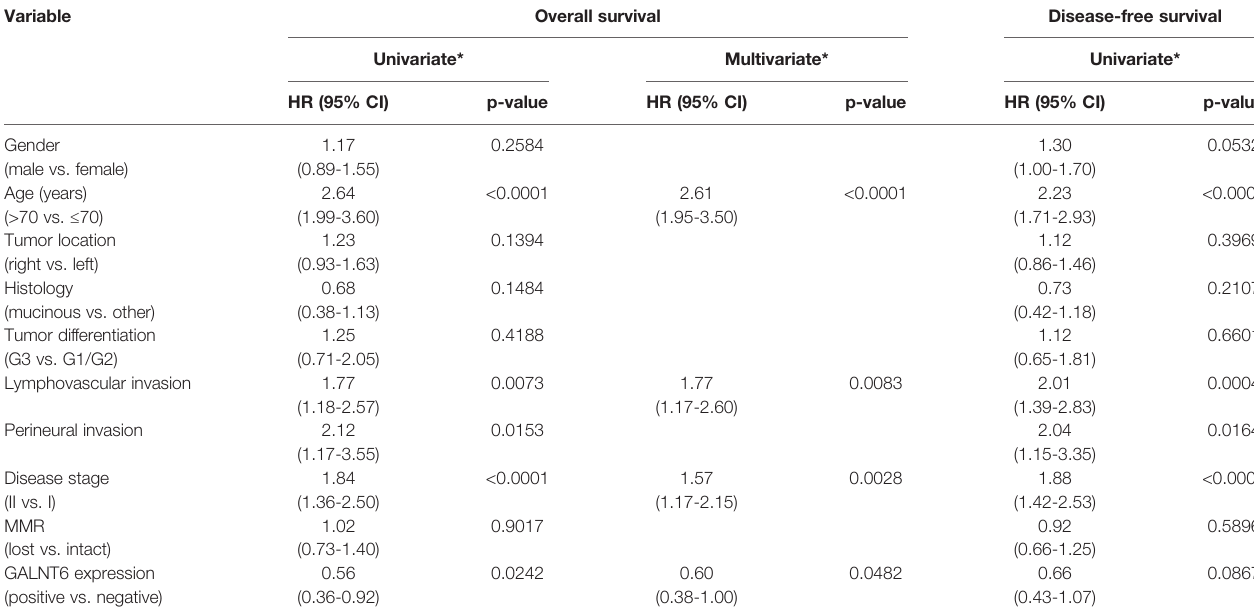
TABLE 2 | Prognostic potential of GALNT6 protein expression in early-stage colorectal cancer.